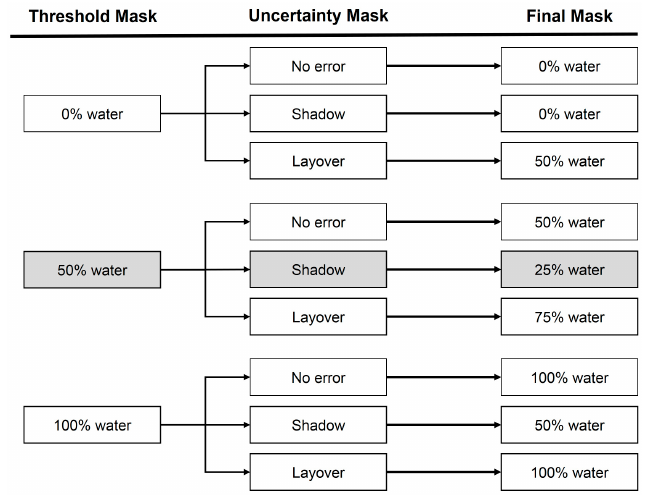
Figure 4. Decision tree analysis performed to create the final SAR water mask by combining the SAR threshold water mask with the shadow and layover zones with in text example highlighted in grey.